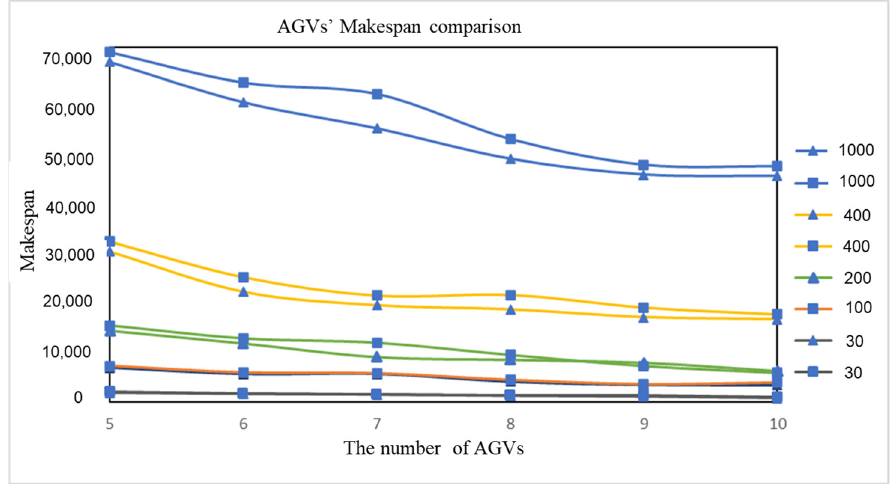
Figure 9. Maximum completion of AGV comparison with/without collision avoidance.